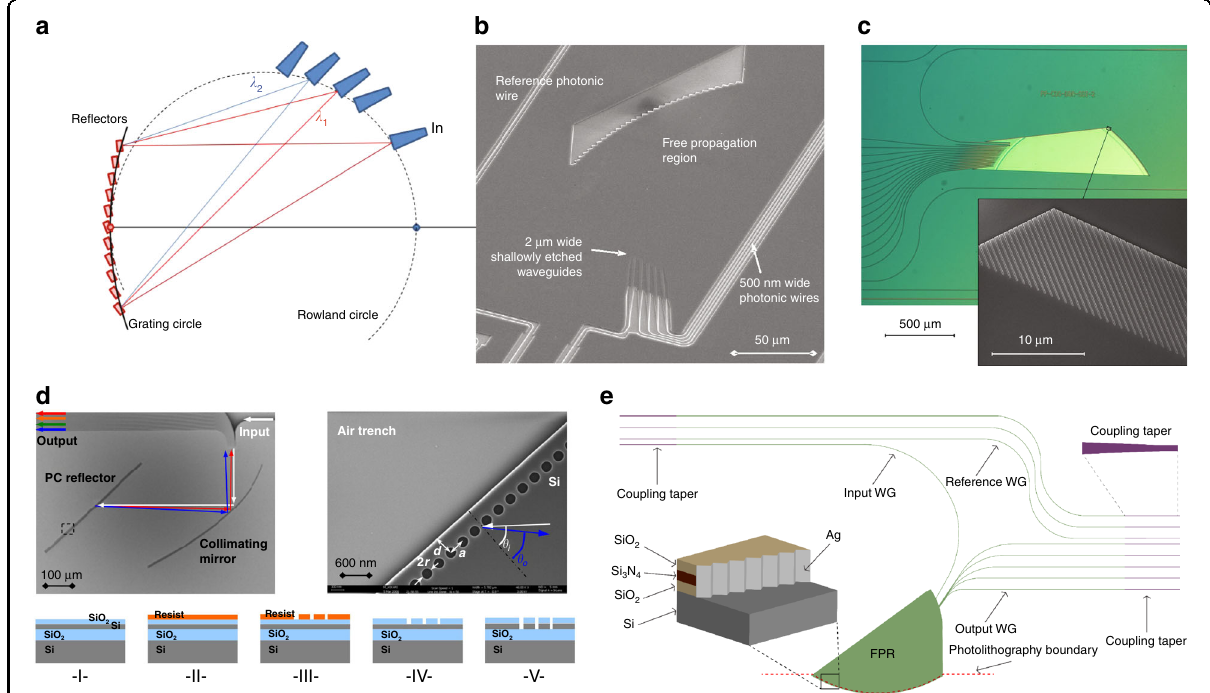
Fig. 7 PCG based spectrometers on silicon photonics platform. a Schematic illustration of a PCG spectrometer. b SEM image of a silicon PCG spectrometer 62 . c – e PCG spectrometers with Bragg re fl ectors 63 , photonics crystal re fl ector 65 , and coating grating with silver fi lms 66 , respectively. b Reprinted from ref. 62 with permissions from IEEE Publishing. c Reprinted with permission from ref. 63 . Copyright 2014 American Chemical Society. d Reprinted from ref. 65 with permission from IOP Publishing. e Reprinted from ref. 66 with permission from IEEE